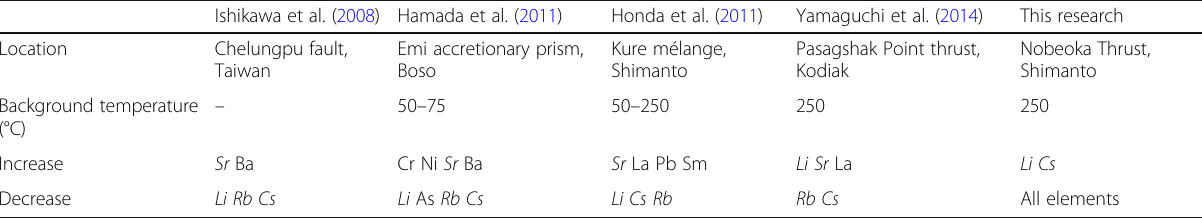
Table 1 Comparison of fault rock chemical composition anomaly in this study and other fields Ishikawa et al. (2008) Hamada et al.